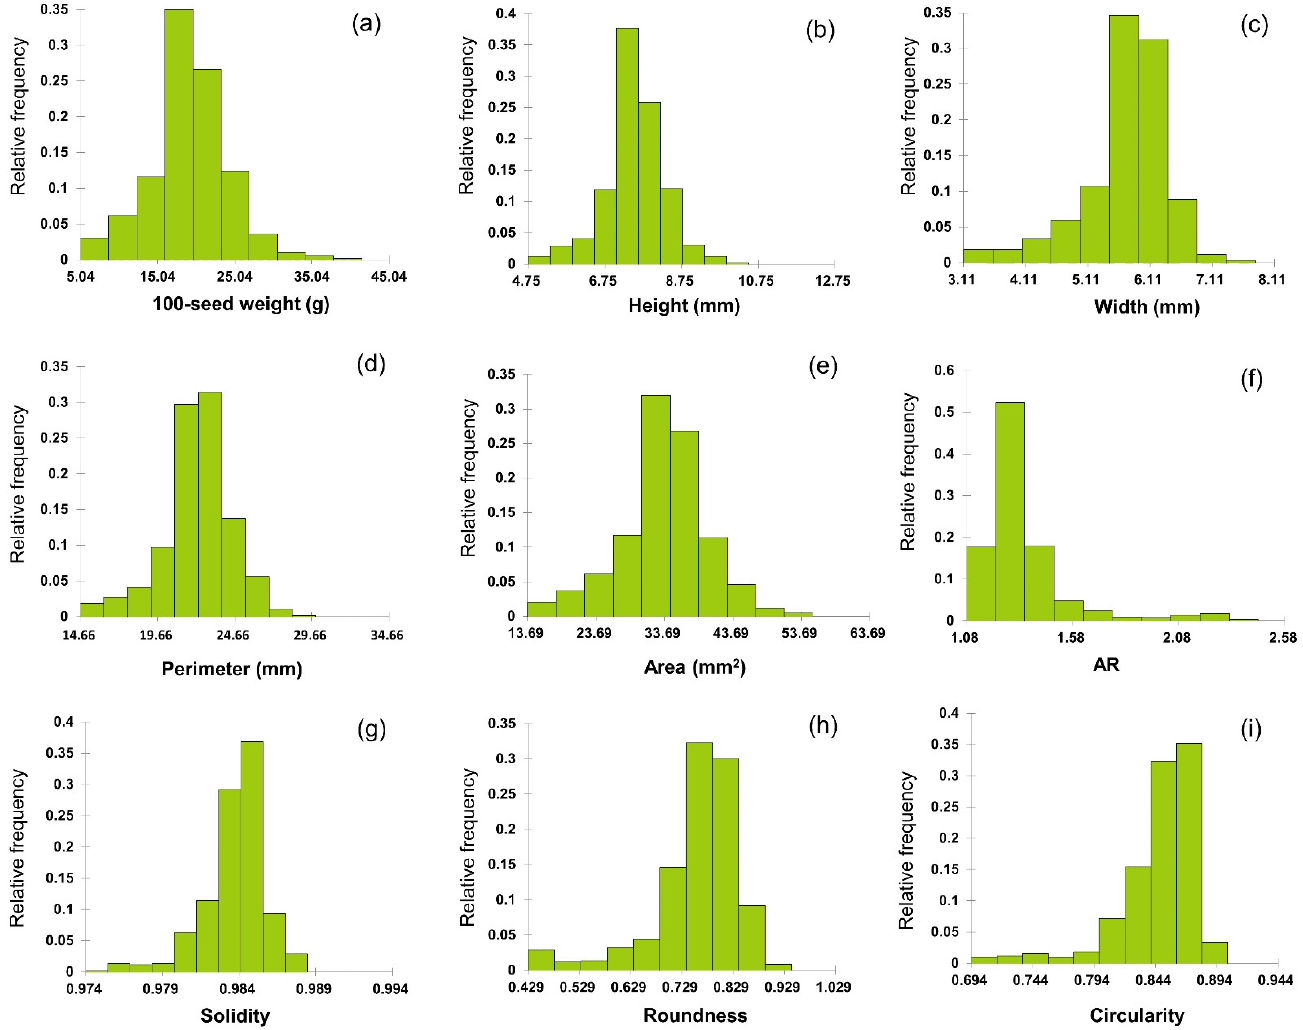
Figure 2. Histogram of seed morphological traits of 589 germplasms. ( a ) 100 ‐ seed weight is the measured value. ( b ) height, ( c ) width, ( d ) perimeter, and ( e ) area are the values measured directly as primary parameters, and ( f ) AR, ( g ) solidity, ( h ) roundness, and ( i ) circularity are values obtained by formulating the values of the primary parameters.